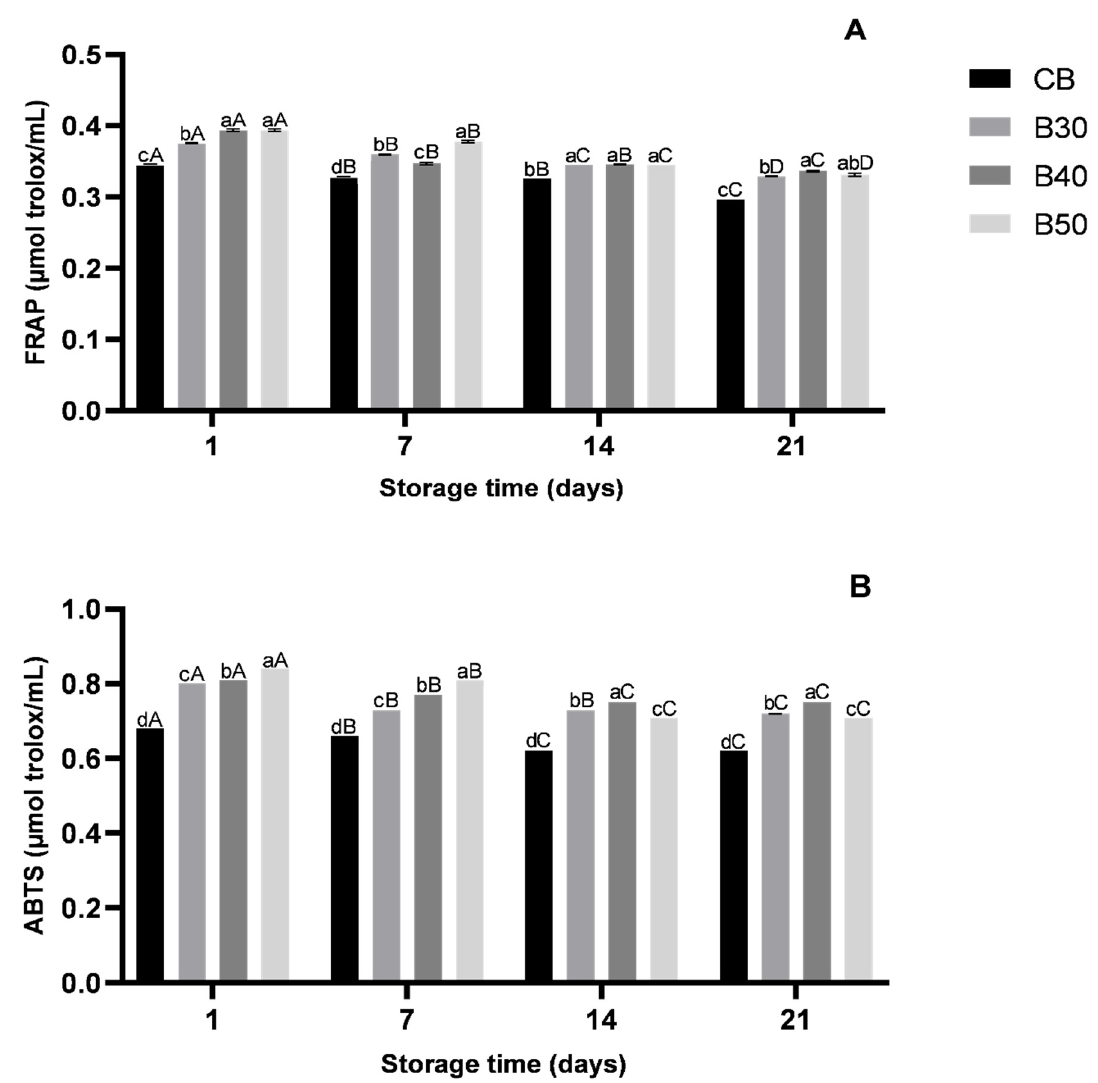
Figure 2. Antioxidant activity in formulated beverages during 21 days of refrigeration storage (4 °C) by ( A ) ferric reducing antioxidant power (FRAP, µmol Trolox/mL) and ( B ) ABTS radical cation scavenging activity (µmol Trolox equivalent/mL). Error bars represent the standard deviation of the mean ( n = 3). Different lowercase letters on the same storage time period differ ( p < 0.05) among formulated beverages, and different uppercase letters on the same beverage formulation differ ( p < 0.05) among different storage time periods based on Tukey’s test. CB—control beverage; B30—beverage with 30% of xique-xique cladode juice; B40—beverage with 40% of xique-xique cladode juice; B50—beverage with 50% of xique-xique cladode juice.